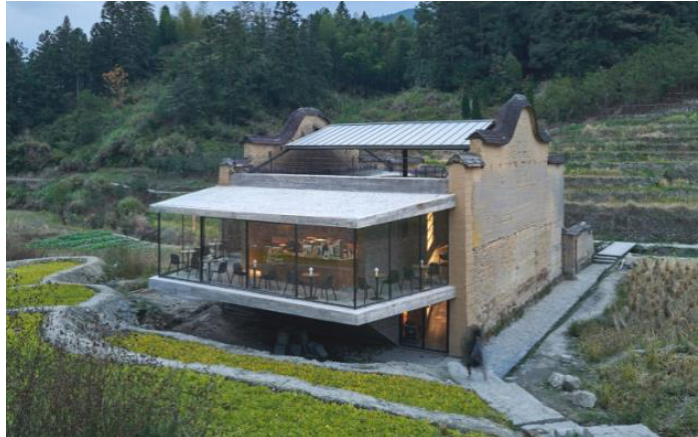
Figure 24. The transformed Paddy Bookstore (source: [50]).